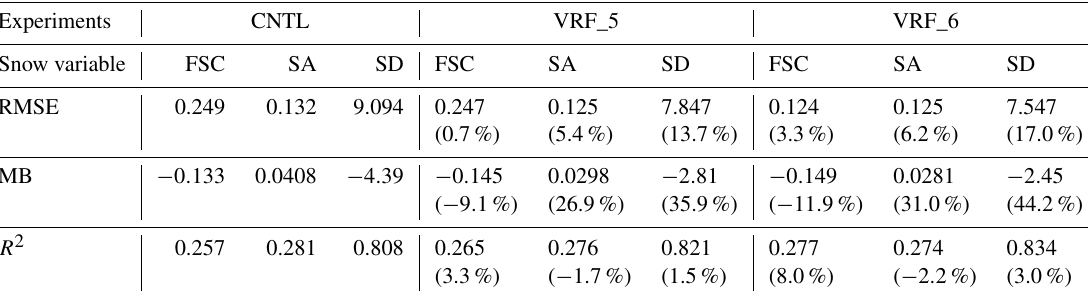
Figure 5. Box plots of (a) FSC bias, (b) SA bias, and (c) SD bias (cm) for CNTL, VRF_5, and VRF_6. The maximum differences are indicated with the black star symbol (e.g., 0.637 (CNTL), 0.643 (VRF_5), 0.570 (VRF_6) for FSC, 0.605 (CNTL), 0.563 (VRF_5), and 0.525 (VRF_6) for SA and 34.1cm (CNTL), 45.1cm (VRF_5), and 46.3cm (VRF_6) for SD). Each mean of snow variables is indicated as a black circle (e.g., − 0 . 133 (CNTL), − 0 . 145 (OPT_5), and − 0 . 149 (VRF_6) for FSC, 0.0408 (CNTL), 0.0298 (VRF_5), and 0.0281 (VRF_6) for SA and − 4 . 39cm (CNTL), − 2 . 81cm (VRF_5), and − 2 . 45cm (VRF_6) for SD). Table 4. The RMSE, MB, and R 2 of snow variables and improvement ratios (%) in parentheses from CNTL to VRF_5, and VRF_6 over the 25 representative stations. The difference between CNTL and verification experiments (i.e., VRF_5 and VRF_6) has 95% statistical significance, as evaluated with a two-tailed t